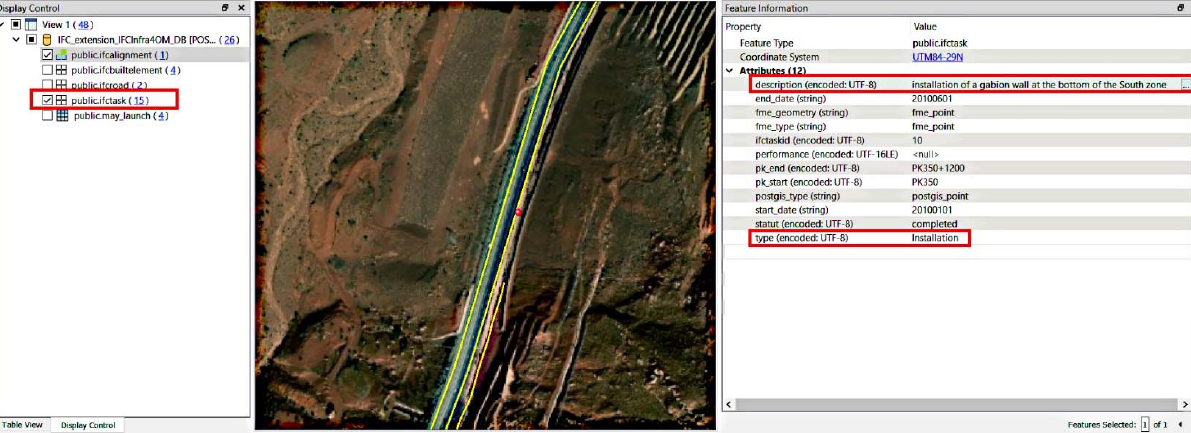
ISPRS Int. J. Geo-Inf. 2021 , 10 , x FOR PEER REVIEW Figure 10. O&M information extraction from IFCTask class and its geolocation on the IFCAlignment entity. Figure 10. O&M information extraction from IFCTask class and its geolocation on the IFCAlignment entity. Figure 10. O&M information extraction from IFCTask class and its geolocation on the IFCAlignment entity.